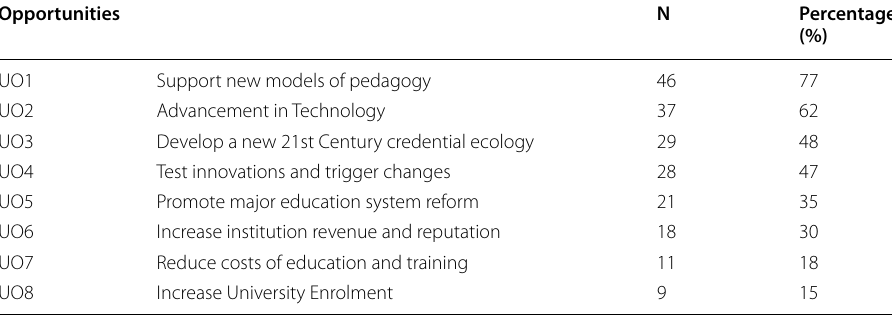
Table 5 Summary view of the opportunities offered by micro-credentials for the higher educational institutions